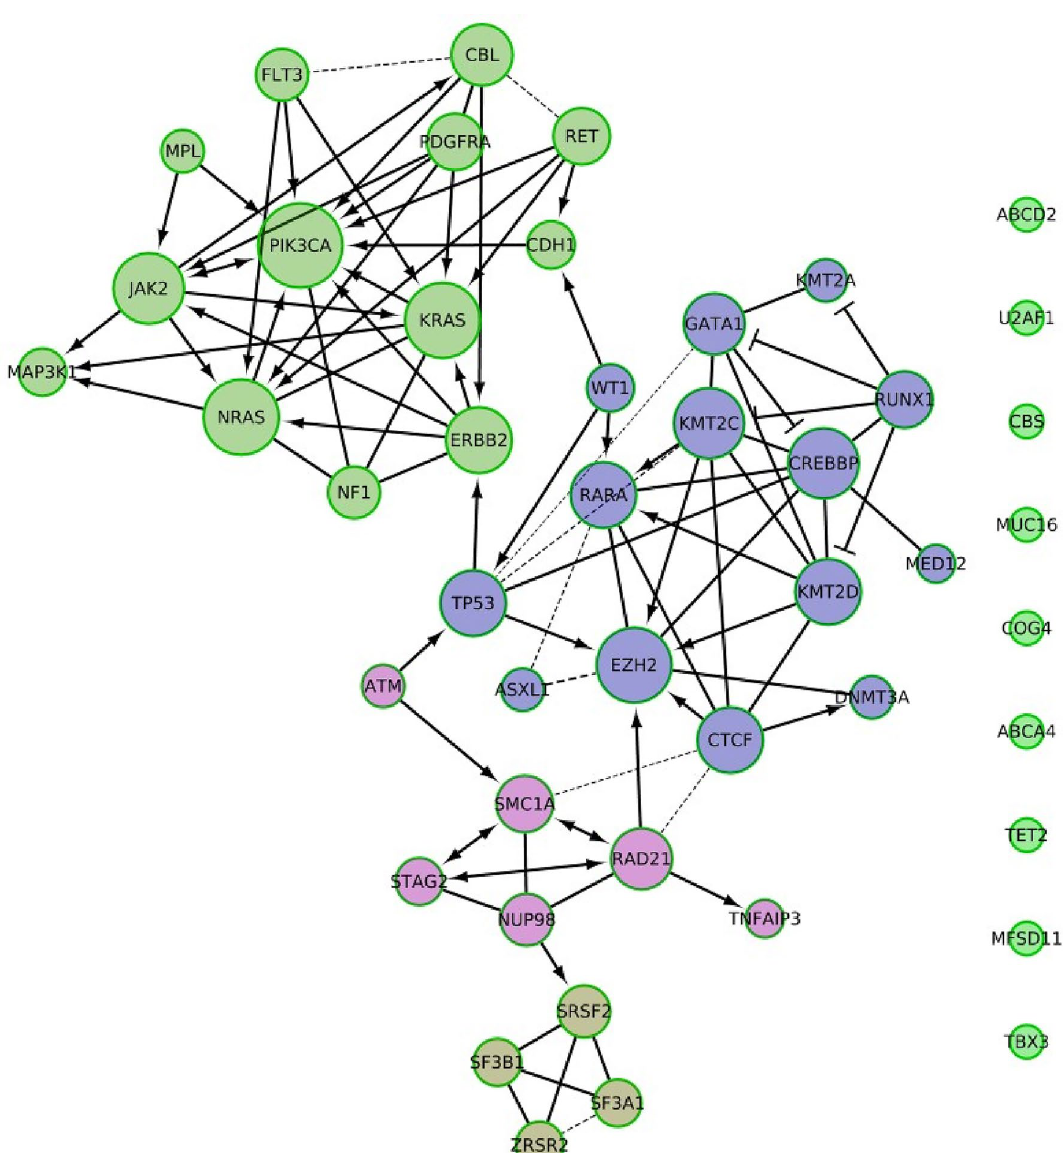
Figure 10. The constructed gene network by Reactome FI plugin in Cytoscape shows in total 42 nodes and 92 edges. The network consists of one giant connected component which contains 37 nodes and 9 disconnected nodes. Edge’s size is mapped to FI score and line type is mapped to FI direction as previously described. Node’s size reflect its degree and nodes’ colors are based on FI